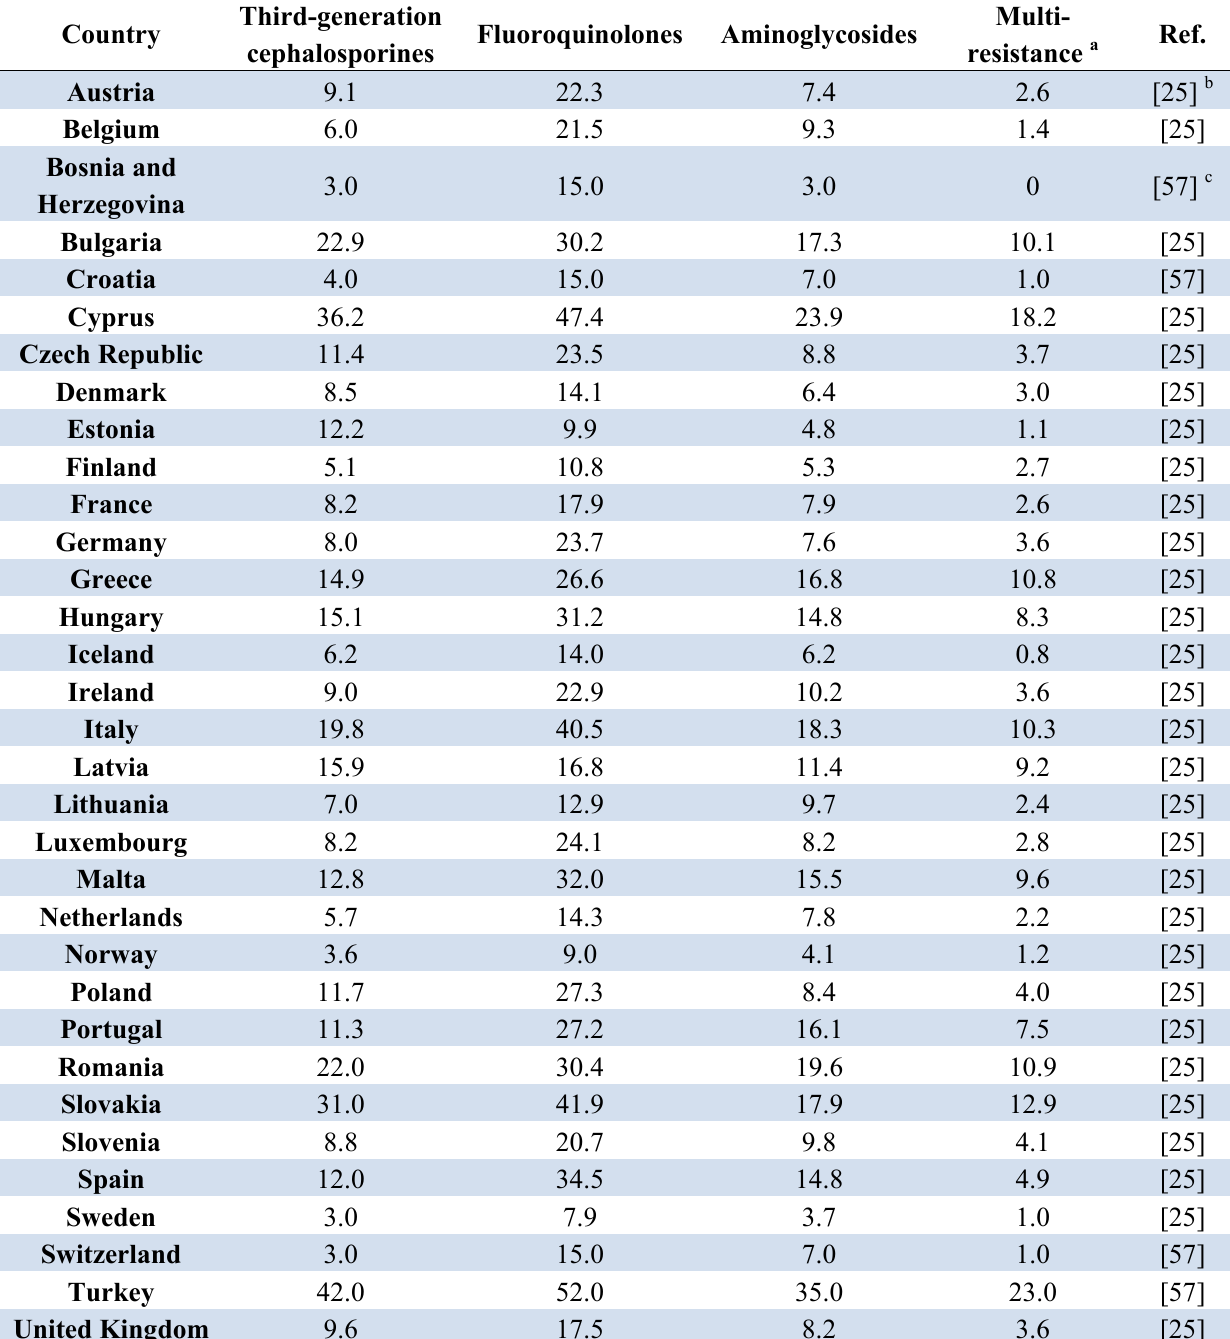
Multi- resistance a